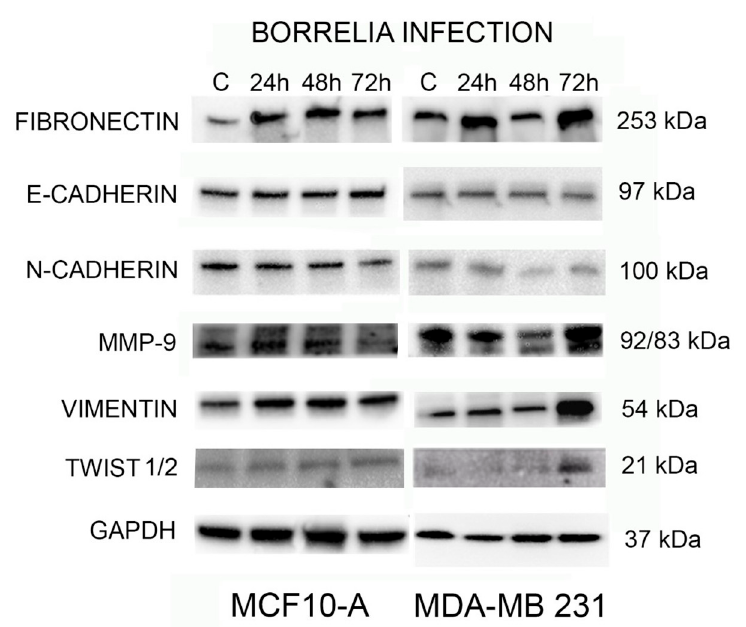
Figure 8. Western blot analysis of expression of EMT-mediating biomarkers and transcription factors: Fibronectin, E-Cadherin, N-Cadherin, MMP-9, Vimentin, and Twist1/2 with loading control GAPDH and uninfected control cells (cultured only in co-infection media) and B. burgdorferi infected MCF 10A and MDA-MB-231 cells for 24, 48, and 72 h. A representative blot from three independent experiments was shown.